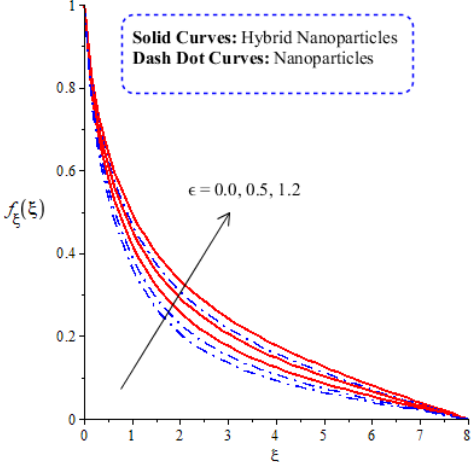
Figure 6. Comparative analysis of velocity in hybrid nanoparticles and nanoparticles versus change in 𝜖 .